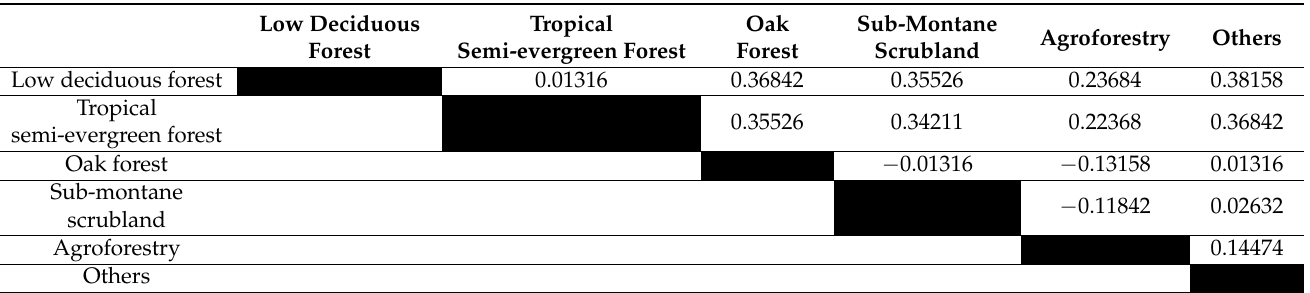
Table 9. Tukey value